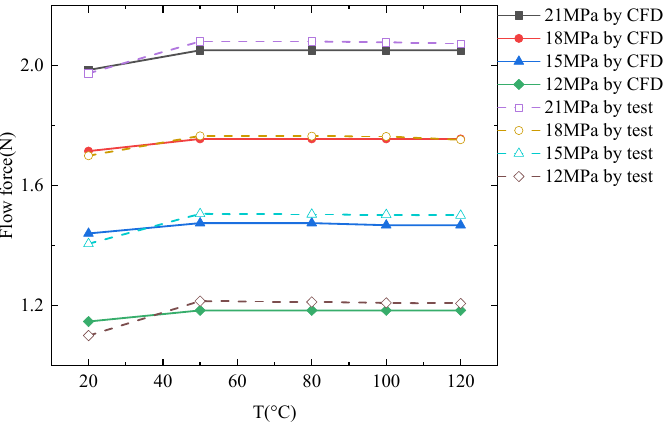
Figure 23. Influence of inlet pressure and temperature variation on flow force.